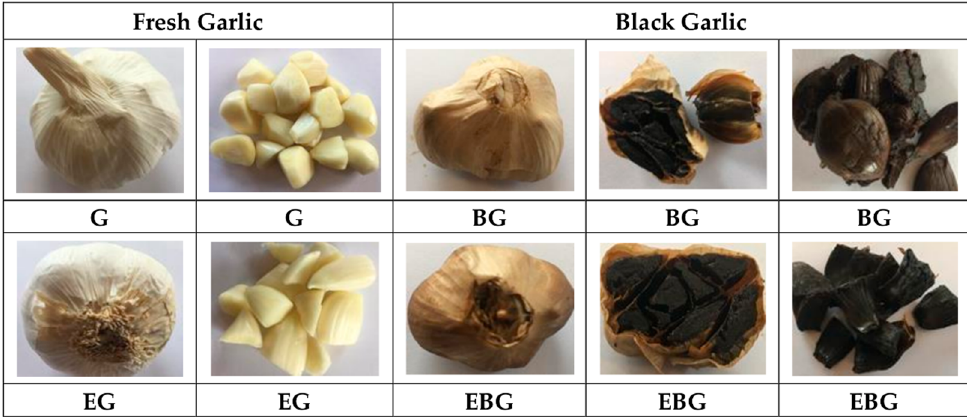
Figure 1. Changes in the appearance of fresh conventional (G) and organic (EG) garlic (bulbs and cloves) during heat treatment (45 days, 70 °C, 80% humidity). G—fresh conventional garlic; EG—fresh organic garlic; BG—conventional black garlic; EBG—organic black garlic. Table 1. Physicochemical characterization of white and black garlic from conventional and organic cultivation.